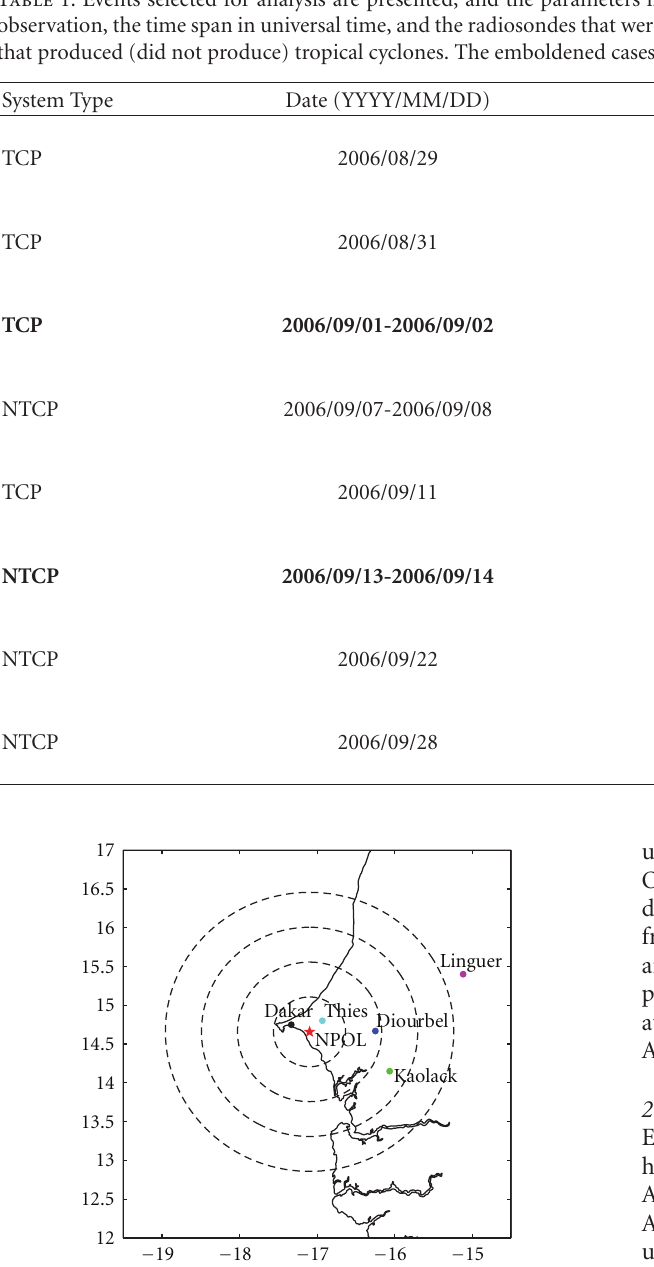
Figure 1: Map showing the sampling region of NPOL. The range rings are in 50 km intervals. Various Senegalese cities are shown along with the location of NPOL to provide a frame of